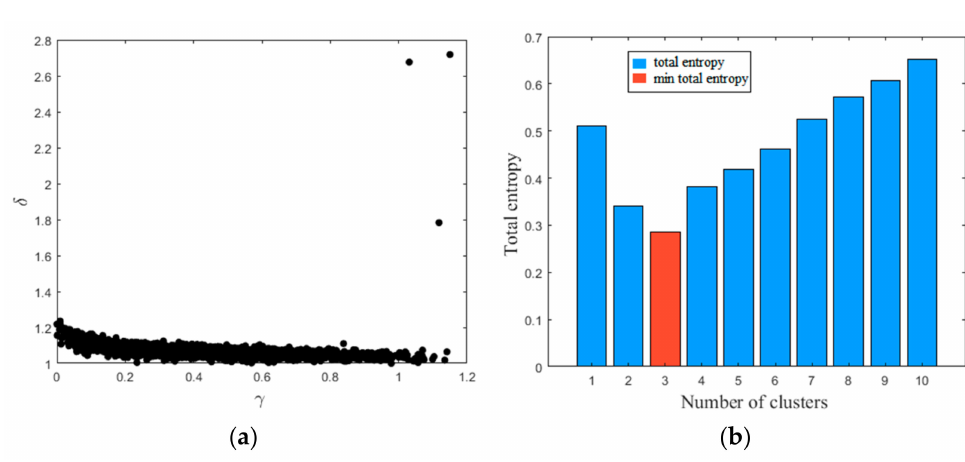
Figure 8. MDPC on the multimode normal data of TE process: ( a ) γ − δ decision graph; ( b ) total entropy with different number of